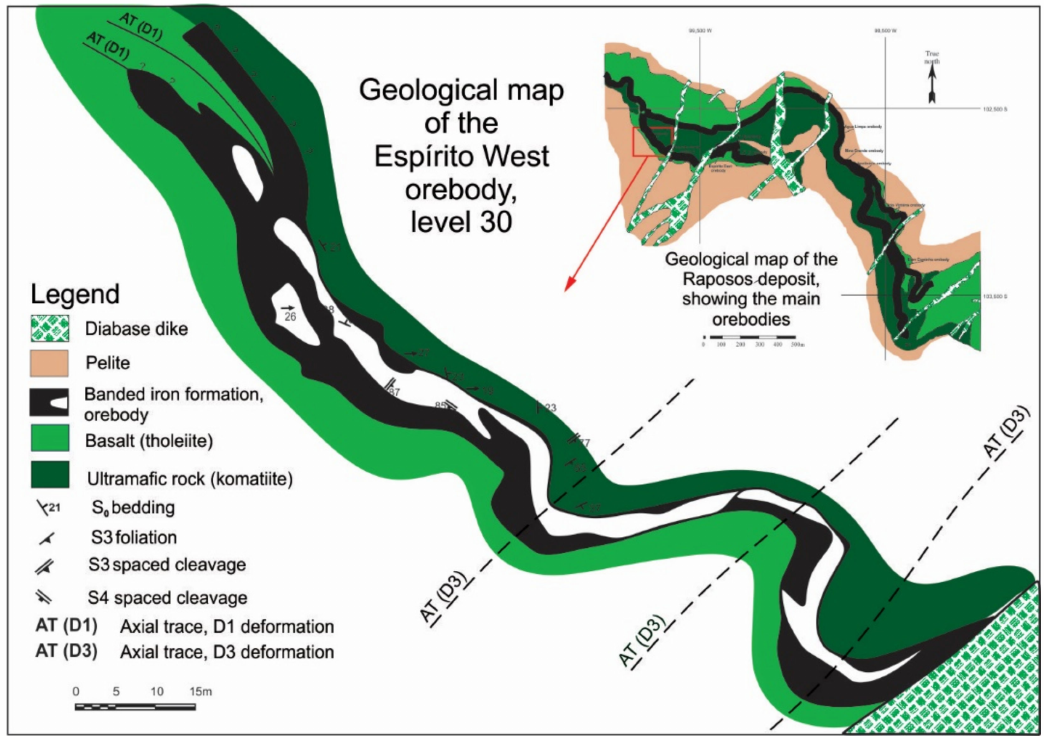
Figure 14. Paleoproterozoic open folds in the Raposos deposit area (modified after